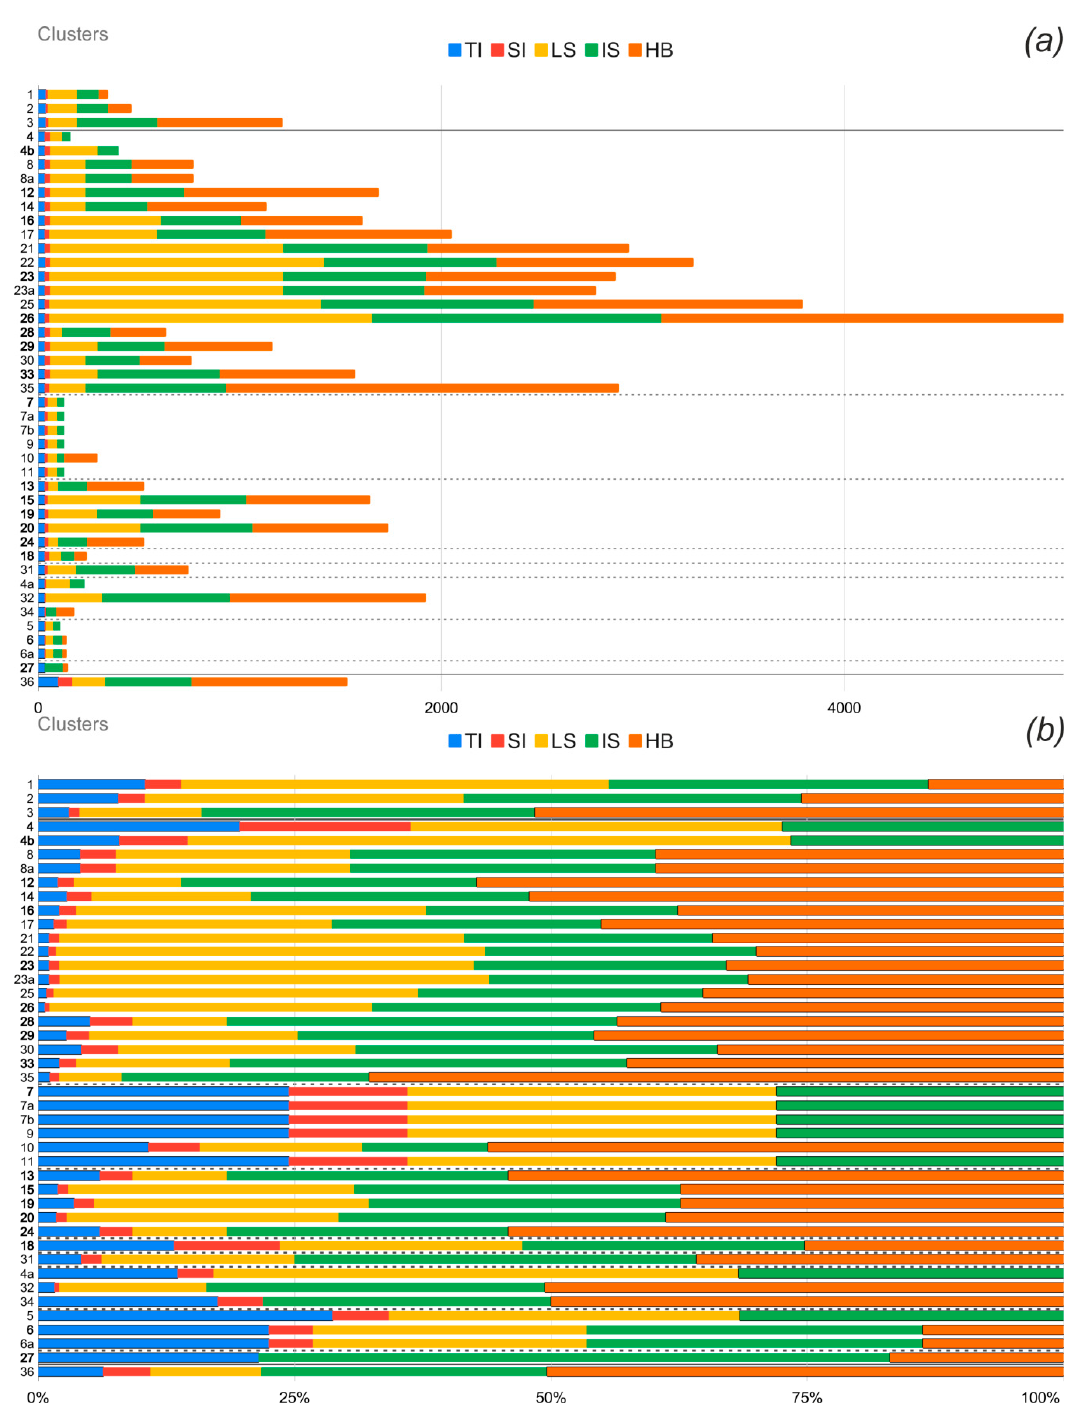
Figure 5. Ladder diagrams showing contributions to structural complexity (bits per unit cell) ( a ) and normalized contributions (in %) ( b ) for the structures based on uranyl carbonate finite clusters. Legend: TI = topological information; SI = structural information; LS = layer stacking; IS = interstitial structure; HB = hydrogen bonding. See Table 2 and text for details.